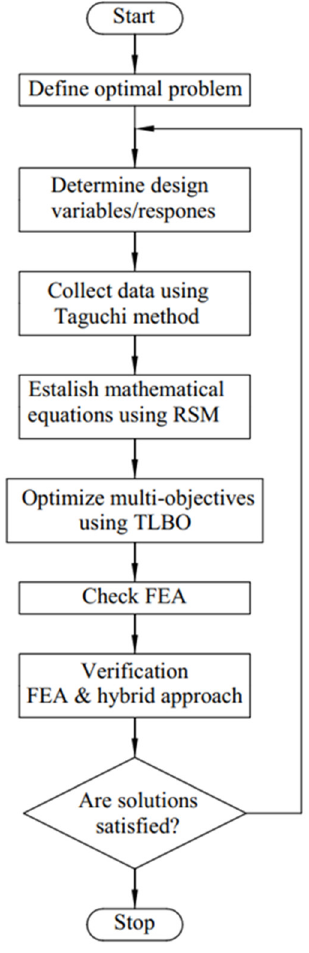
Figure 12. Flowchart of the combined optimization method.